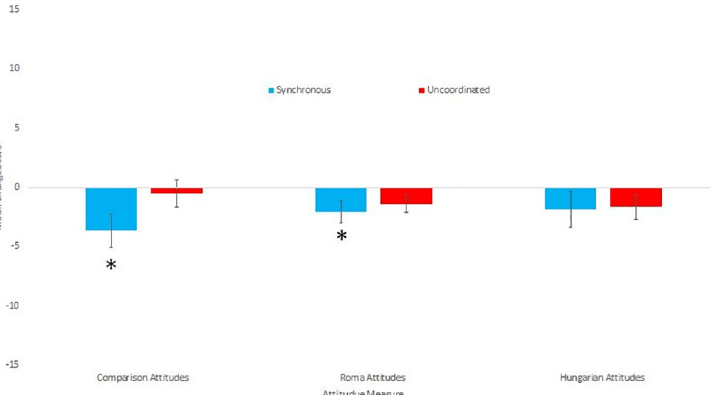
Fig 7. Means and standard errors for Attitude change scores for Study